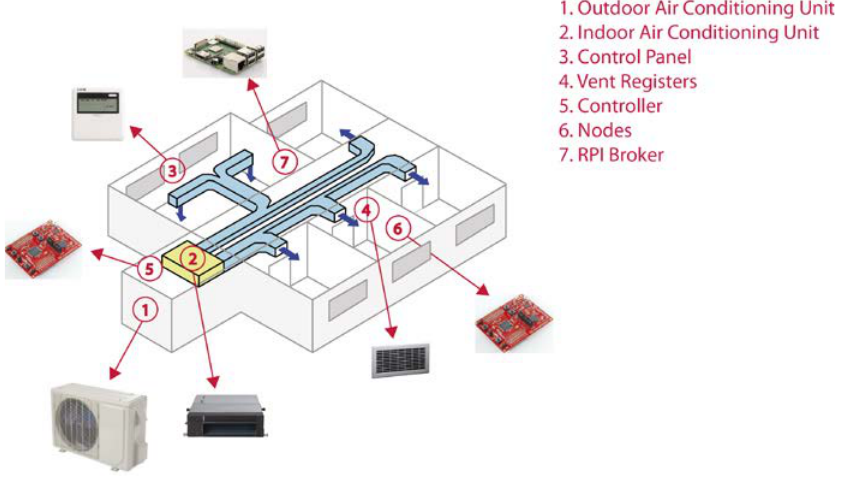
Figure 2. Example of distribution of the main elements of the proposed system.